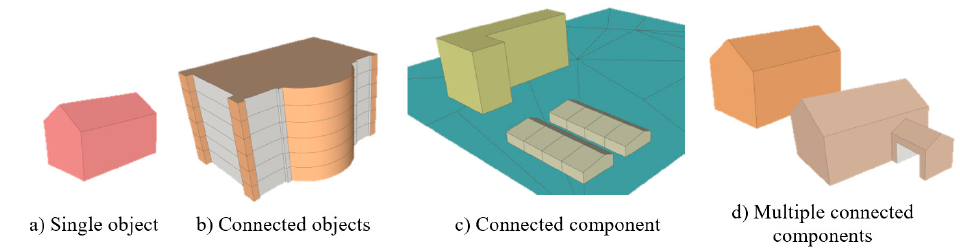
Figure 14. Illustration of connected components and multiple connected components.